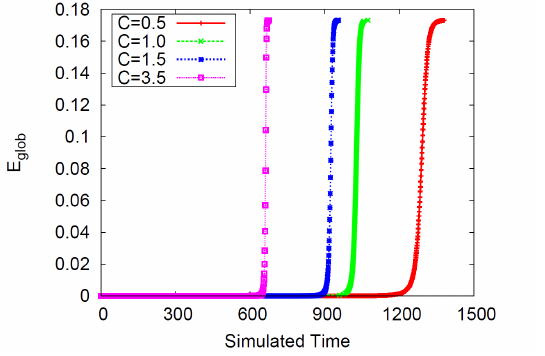
Figure 2. How the scale parameter C influences the global efficiency curve. It directly impacts the time span needed to get the referring network E glob . Algorithm 1: Parallel networks